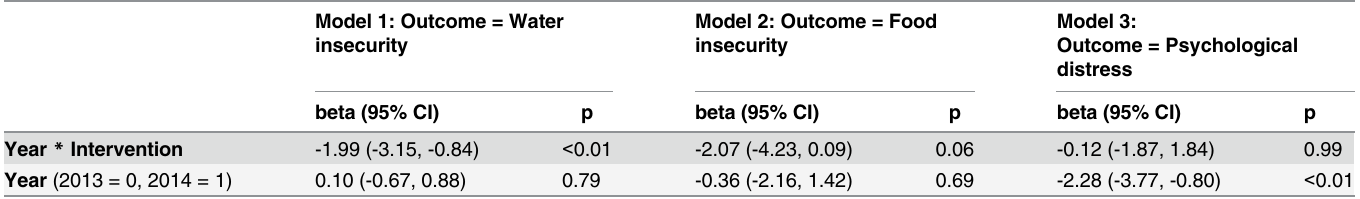
Table 4. Impacts of water improvement on household water insecurity and women ’ s psychological distress: Repeated-measures linear regres- sion, with fixed-effects estimator (n = 123).